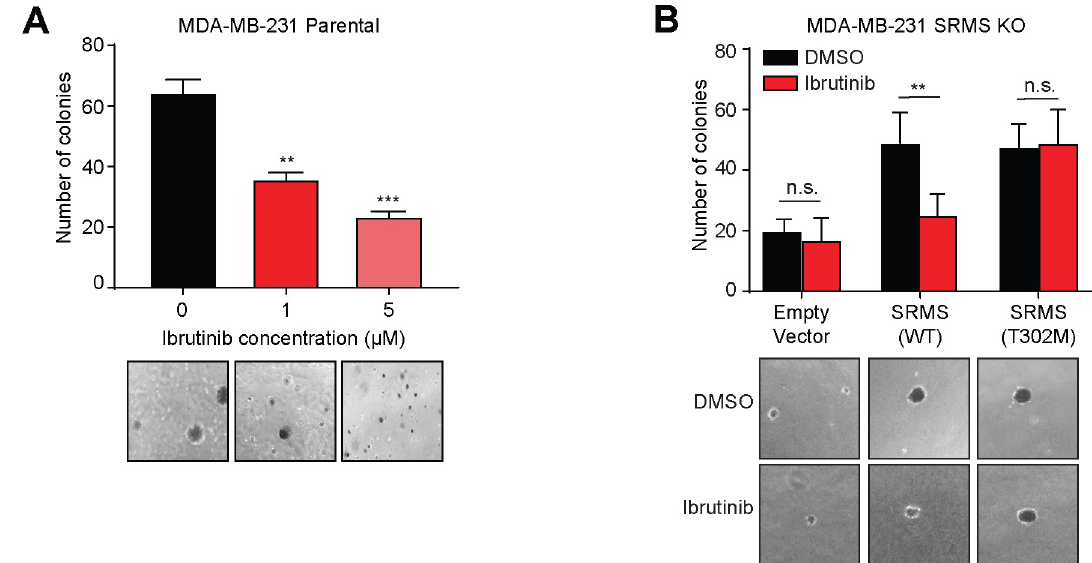
Fig 8. Ibrutinib inhibits cancer cell growth through direct inhibition of SRMS. ( A ) Ibrutinib suppresses anchorage-independent growth. MDA-MB-231 cells were sparsely seeded in soft agar and treated with DMSO or the indicated concentration of ibrutinib for 23 days. Mean + standard deviation of n = 3 replicates is shown along with representative images. �� p < 0.01, ��� p < 0.001. ( B ) SRMS kinase activity promotes anchorage-independent growth. The indicated constructs were expressed in SRMS KO MDA-MB-231 cells. The cells were sparsely seeded in soft agar and treated for 20 days with DMSO or 0.5 μ M ibrutinib. Mean + standard deviation of n = 3 replicates is shown along with representative images. ns p > 0.05, �� p < 0.01. The data underlying the figure can be found in S1 Data. KO, knockout; n.s., non-significant ( p > 0.05); SRMS, Src-related kinase lacking C-terminal regulatory tyrosine and N-terminal myristylation sites; WT,